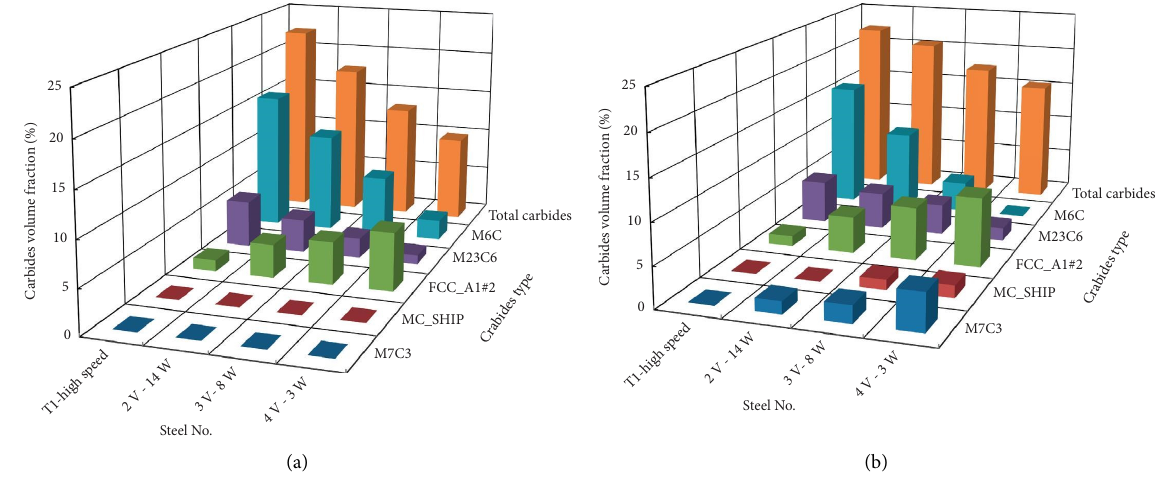
Figure 18: Carbide volume fraction for heat-treated investigating steel. (a) Vanadium-modifed steel; (b) vanadium with extra carbon- modifed